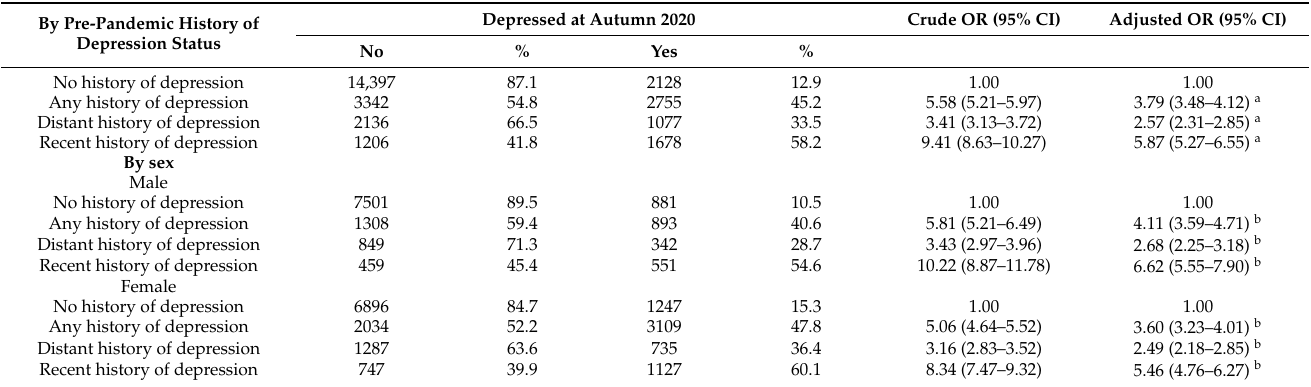
Table 5. Crude and adjusted odds ratios and 95% confidence intervals of being depressed during Autumn 2020 based on pre-pandemic history of depression status and